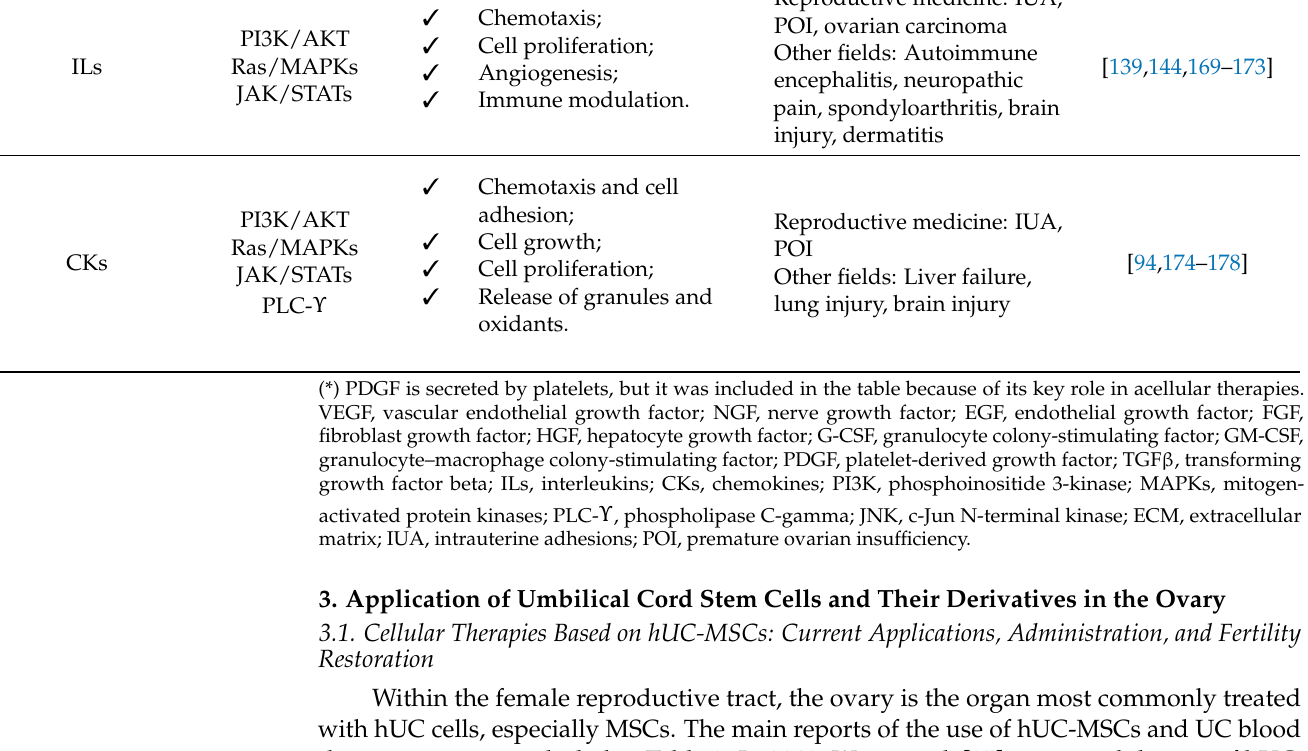
Table 1. Main growth factors secreted by hUC-MSCs and found in the acellular components of hUC blood. For each growth factor, this table lists the most prominent signaling pathways, biological functions, and therapeutic applications reported in the literature in reproductive medicine and other medical fields.